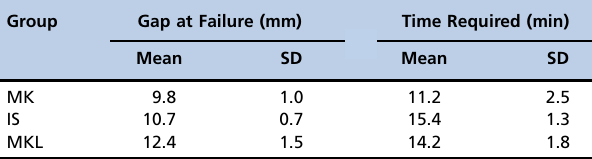
Table 2 - The gaps at failure and times required for three suture techniques. Group Gap at Failure (mm)